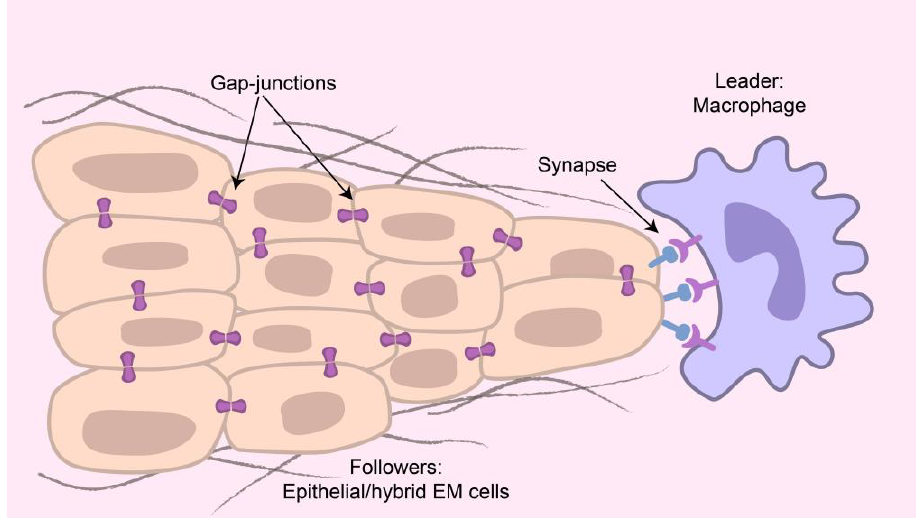
Figure 3. Hypothetical picture of a circulating tumor cell (CTC) cluster with a leader macrophage cell connected by synaptic interactions, with epithelia/hybrid mesenchymal – epithelial followers interacting with each other by means of gap junctions.